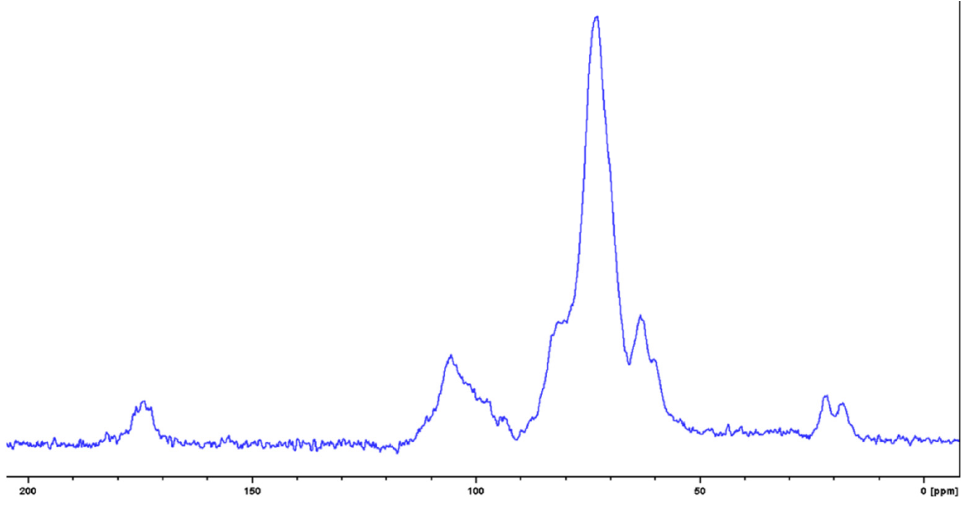
Figure 5. EPS-based sample thermograms: Weight loss (%) (TGA) ( a ) and thermal degradation rate (DTG) ( b ).